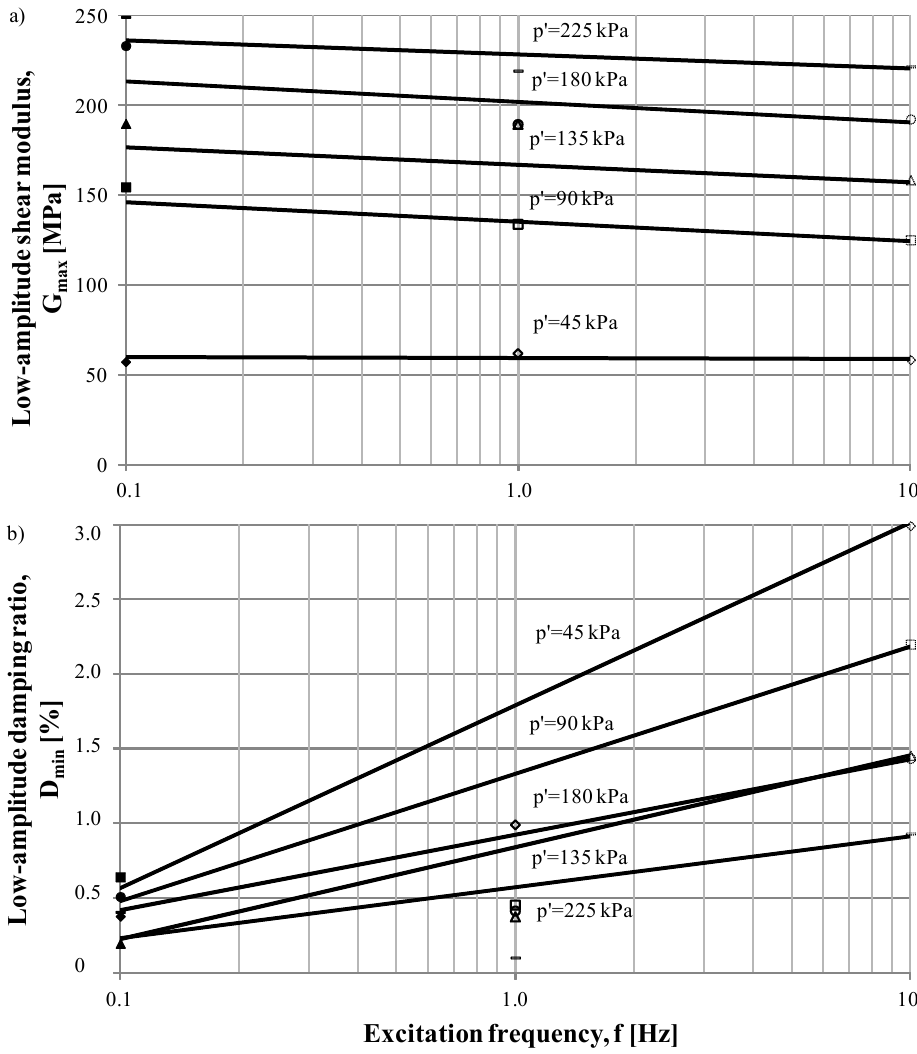
Fig. 10. Low-amplitude shear modulus (a) and low-amplitude damping ratio (b) as a function of excitation frequency for test